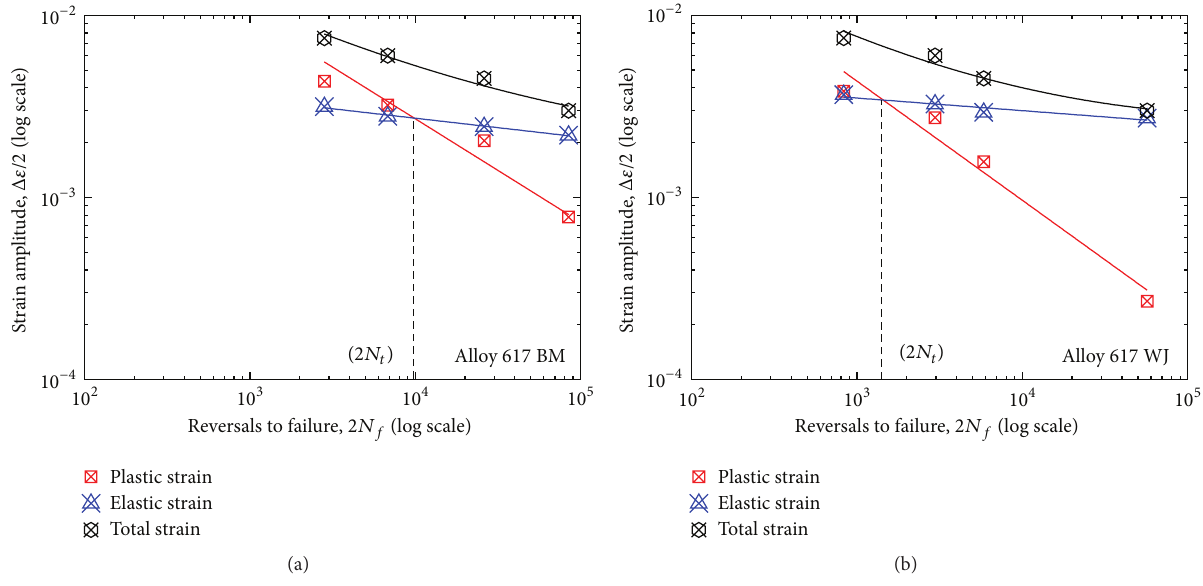
Figure 8: Coffin-Manson equation plots of (a) the BM and (b) the